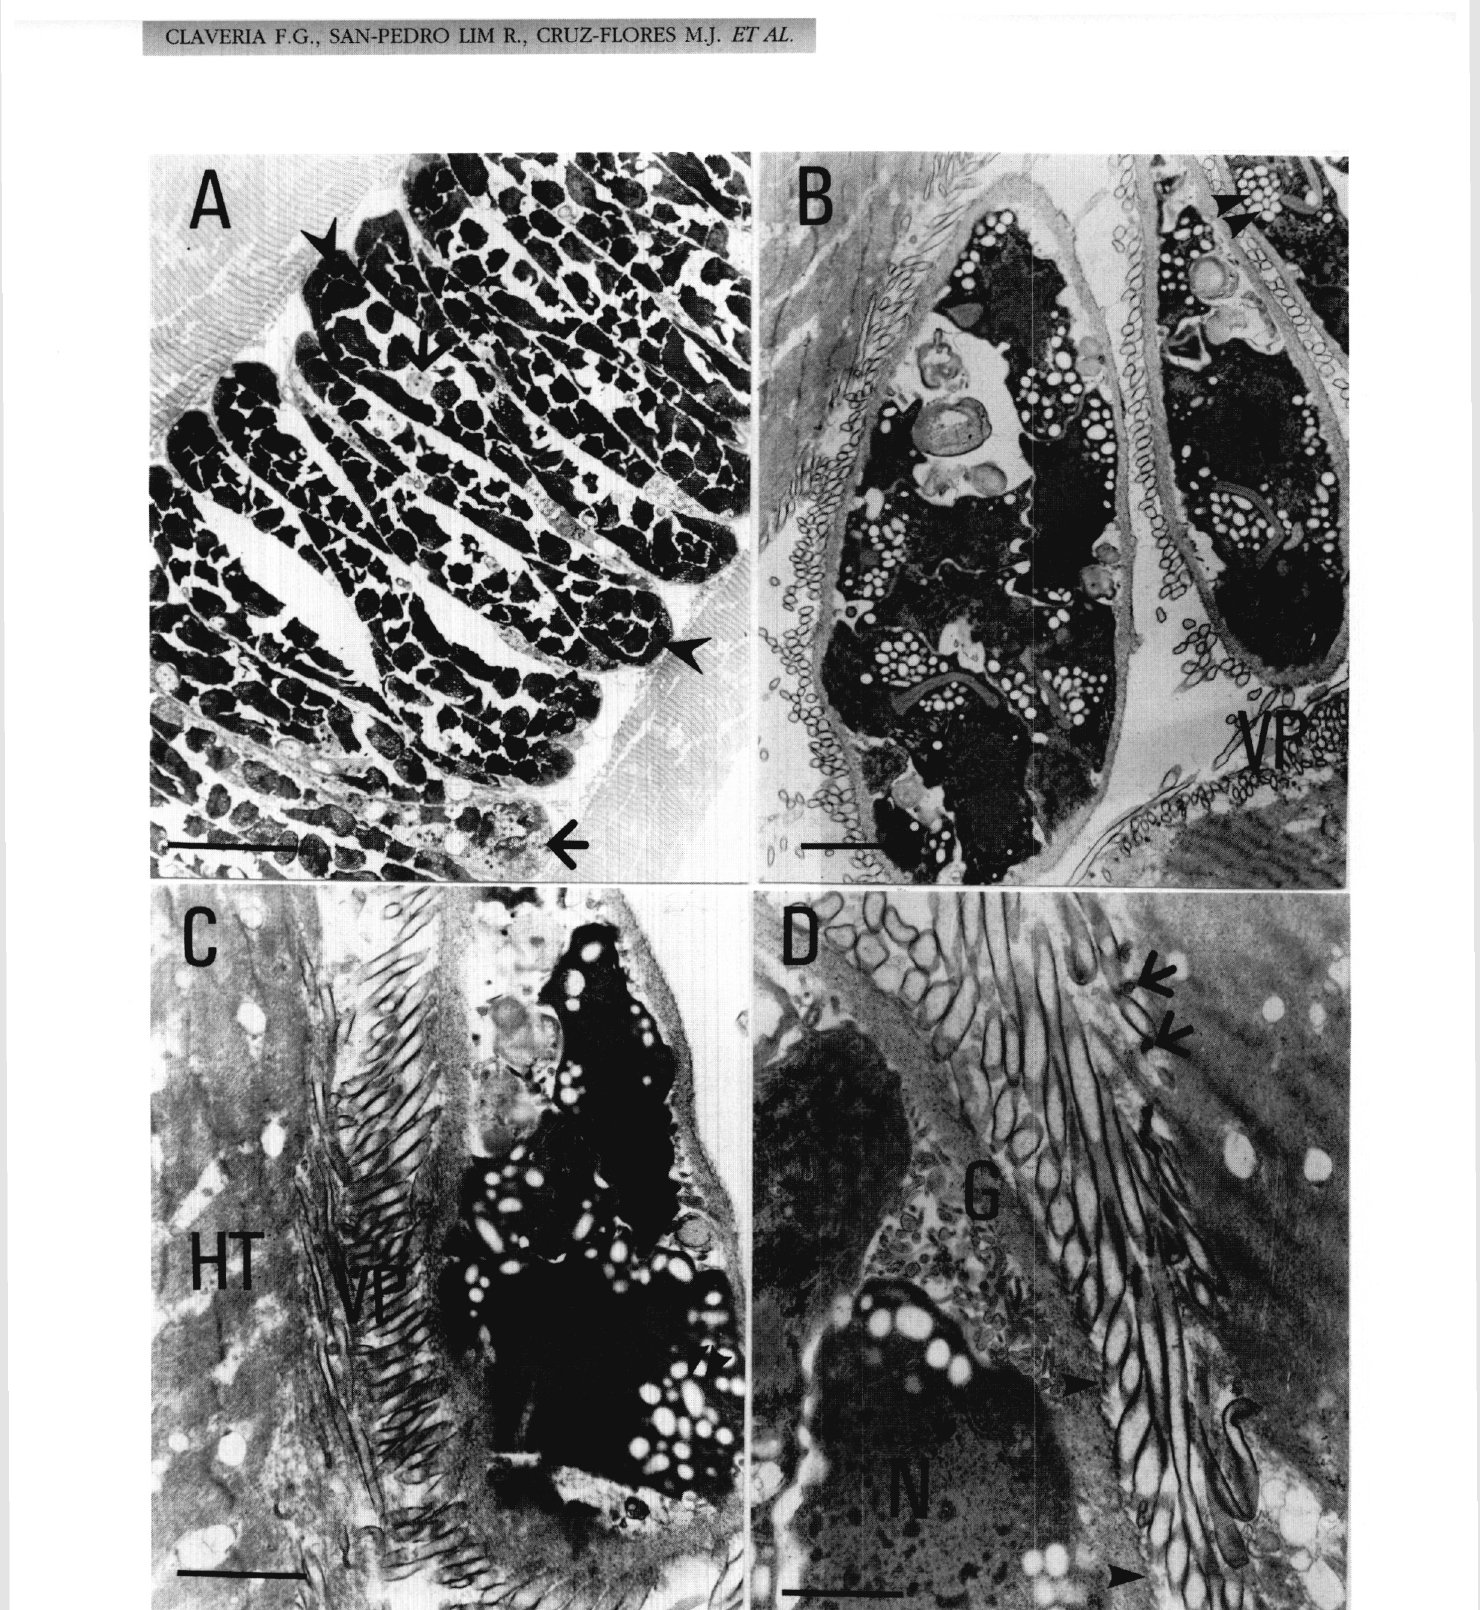
Figs A-D. - Sarcocystic cruzi in bovine cervical muscle tissue section. A. Mature sarcocyst. Bradyzoites (arrowhead); Metrocytes (arrows). Bar: 13 μm. B, C. Young sarcocysts with cross, longitudinal and tangential sections of villar protrusions (VP). Nucleus (N); Amylopectin granules (arrowhead). Bar: B = 2.5 μm; C = 1.7 pm. D. Portion of sarcocyst and its cyst wall. Ground substance (G); Bubble-like undula­ tions (arrowhead); Conical tufts (arrows). Bar = 1 μm. Note marked damage to host muscle tissue (HT) including displacement of